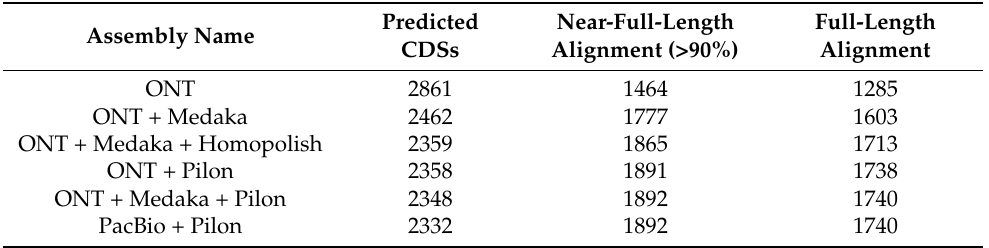
Table 6. Blast alignment of transcripts with CDSs of the assembled genome.